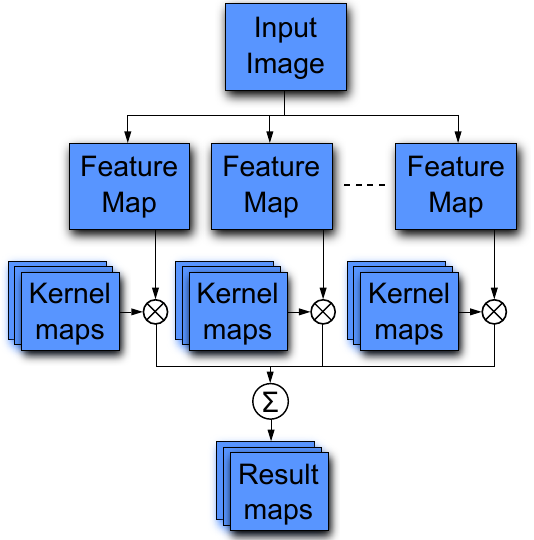
Figure 1: Overview of computations in a regular sliding-window process. The convolution is performed once for each class per feature map, and corresponding convolution results are summed up per class.